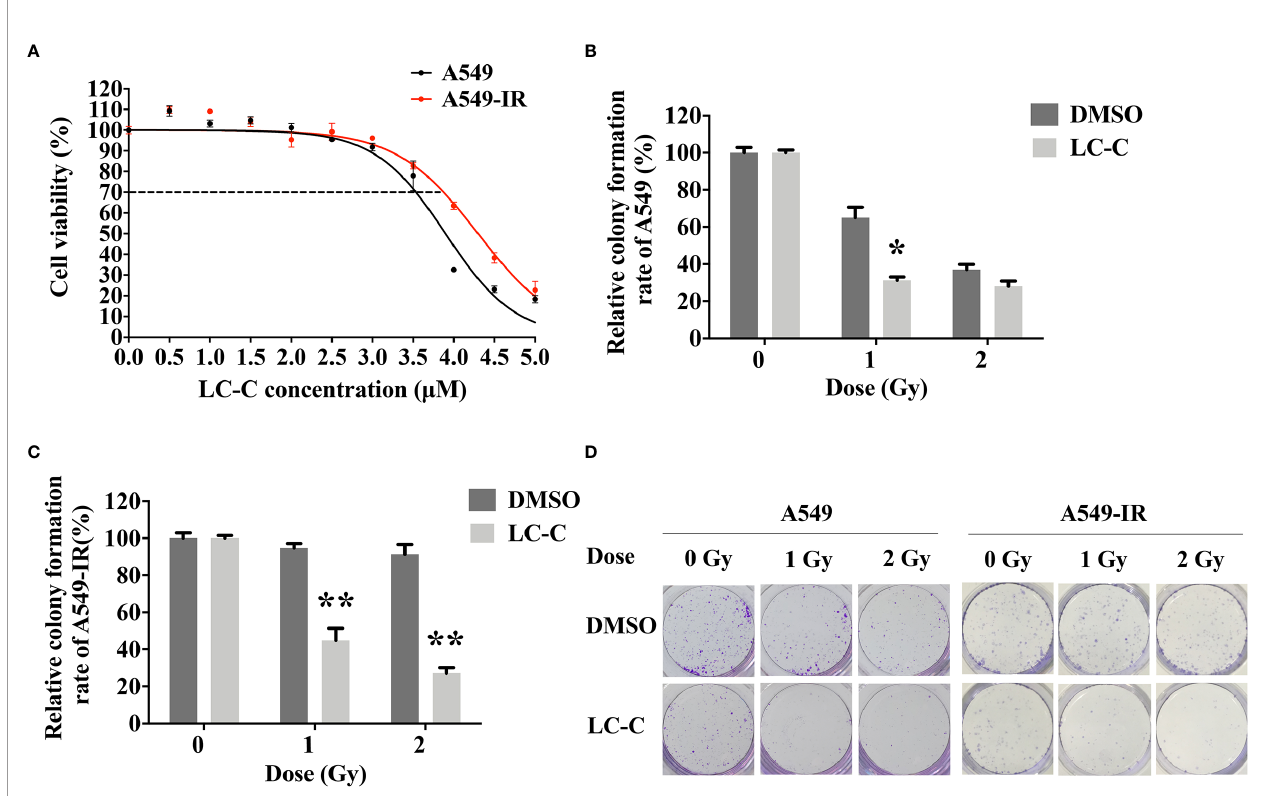
FIGURE 1 | LC-C signi fi cantly enhances the radiosensitivity of A549-IR cells. (A) MTT assay showing the cell viability of A549-IR cells was slightly higher than A549 cells after treatment with LC-C, and the IC 30 dose of LC-C in both cells was about 3.5 m M to 4 m M. (B) A549 cells were pretreated with LC-C (3.5 m M) or DMSO as control for 24 h and were then exposed to indicated dose of radiation. Colony formation assay showed that A549 cells were sensitive to radiation, and LC-C (3.5 m M) only radiosensitized A549 cells after exposure to low dose radiation (1 Gy). (C) A549-IR cells were pretreated with LC-C (3.5 m M) or DMSO as control for 24 h and were then exposed to the indicated dose of radiation. Colony formation assay showed that LC-C signi fi cantly radiosensitized A549-IR cells as SF2 reduced from 0.91 ± 0.05 to 0.27± 0.03. (D) Representative images showing the colony formation of A549 and A549-IR cells. Results shown are the means ± standard deviation. *Signi fi cant difference at P < 0.05 level. **Signi fi cant difference at P < 0.01